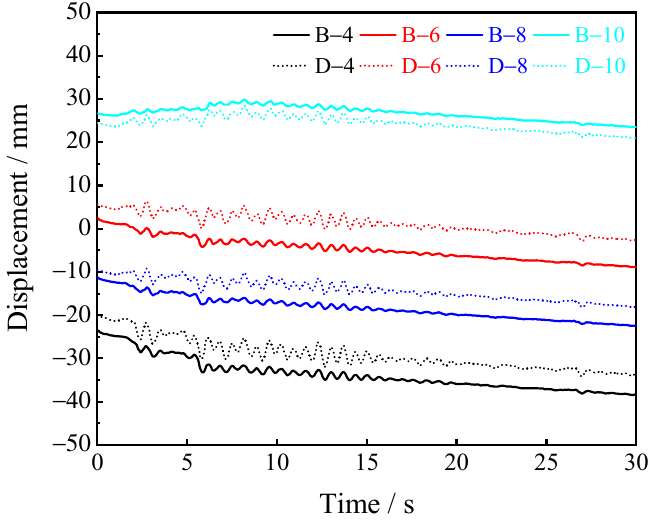
Figure 13. Relative vertical displacement of monitoring points around pilot tunnels under seismic excitation.